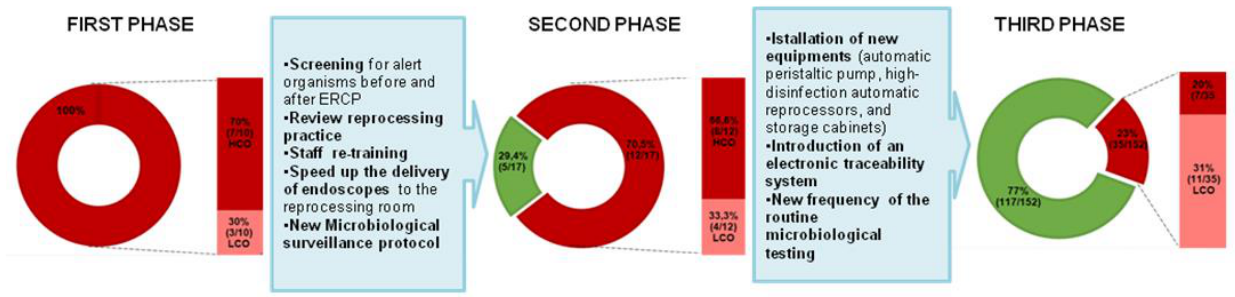
Figure 2. Results obtained during the three phases of the microbiological surveillance. Compliant results in green and non-compliant results in red. Table 1. High-concern organisms identified during the first phase of microbiological surveillance.